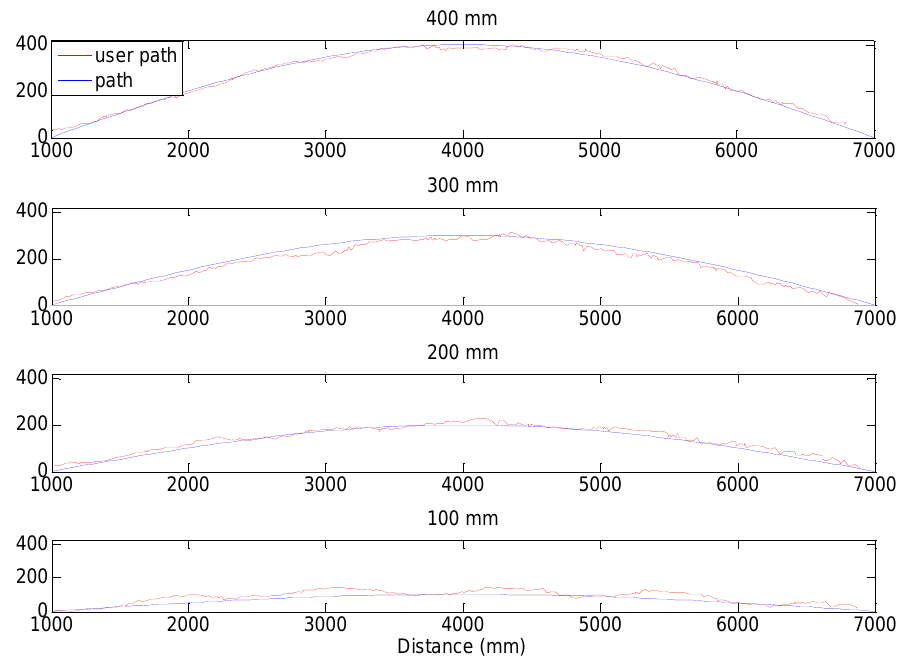
Figure 8. Example of trajectories registered: Half period case.